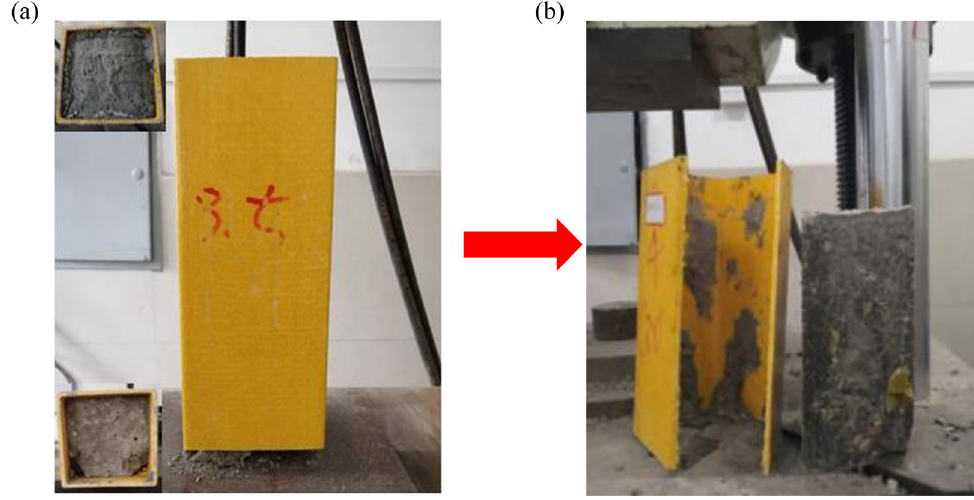
Figure 6: Failure process of specimens: ( a ) before loading and ( b ) after